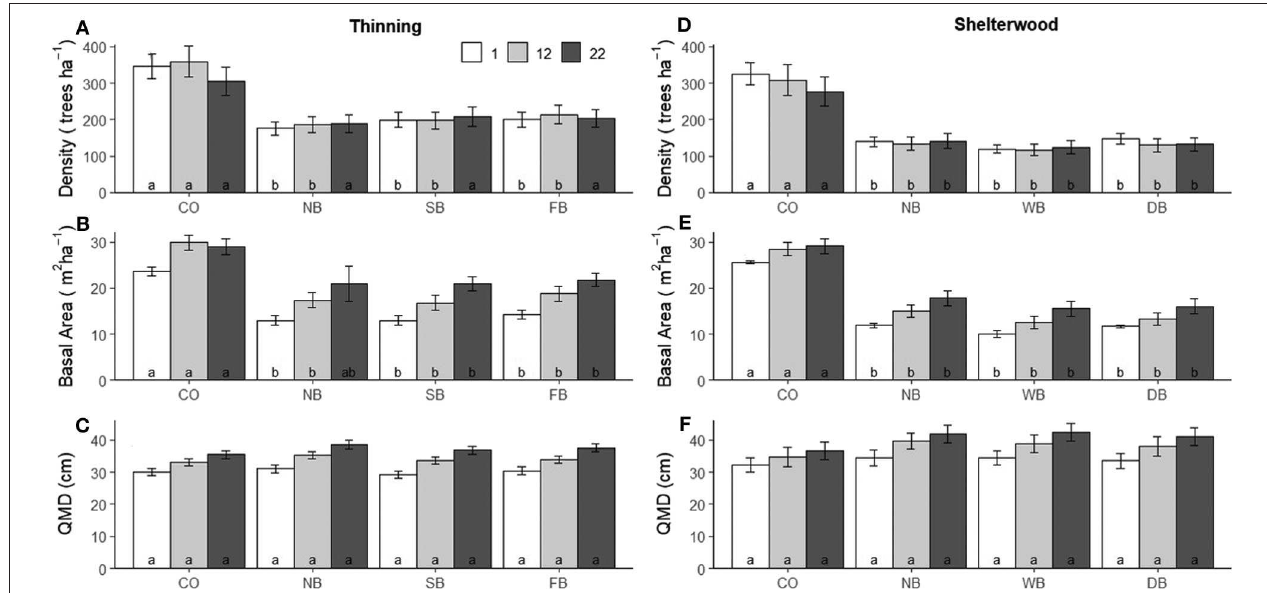
FIGURE 2 | Stand structure characteristics (mean and standard error) for trees ≥ 15.24cm DBH in 1993/94 (1 year post-treatment), 2005 (12 years post-treatment), and 2015 (22 years post-treatment) for (A–C) Thinning and (D–F) Retention Shelterwood. Treatments: CO = Control, NB = Cut, No Burn, SB = Cut + Spring Burn, FB = Cut + Fall Burn, WB = Cut + Wet Burn, and DB = Cut + Dry Burn. QMD = quadratic mean diameter. Different letters denote statistically different treatment values ( α = 0.05) within each time